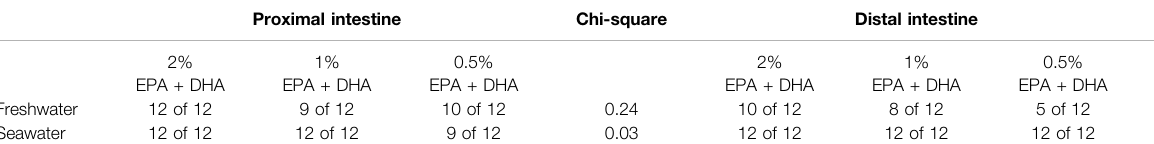
TABLE 6 | Number of intestines displaying serosa positive TEP values in Atlantic salmon freshwater smolts and seawater post-smolts.